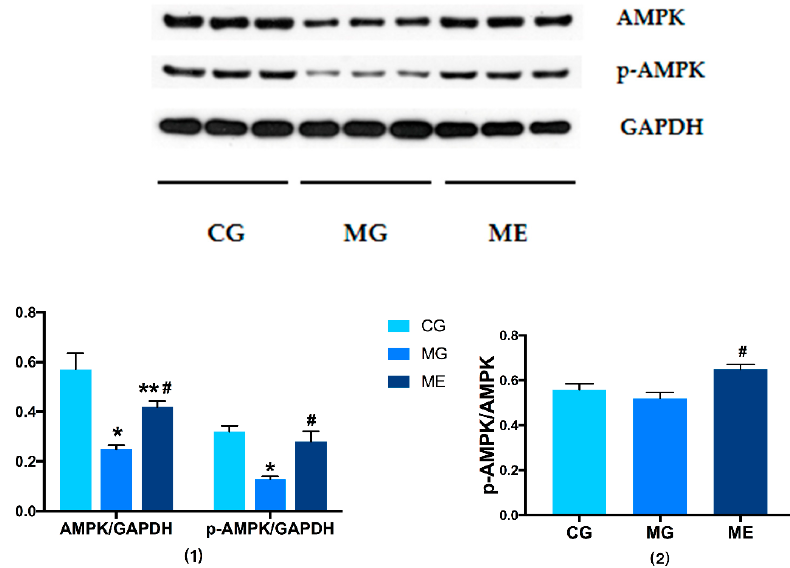
Figure 2. Protein: AMPK, Internal reference protein: GAPDH. (1) shows the results of AMPK / GAPDH and p-AMPK / GAPDH, (2) shows the results of p-AMPK / AMPK. Control Group = CG, Model Group = MG, and Model Exercise Group = ME. * indicates significant di ff erence compared with CG ( p < 0.01); ** indicates significant di ff erence compared with CG ( p < 0.05); # indicates significant di ff erence compared with MG ( p <